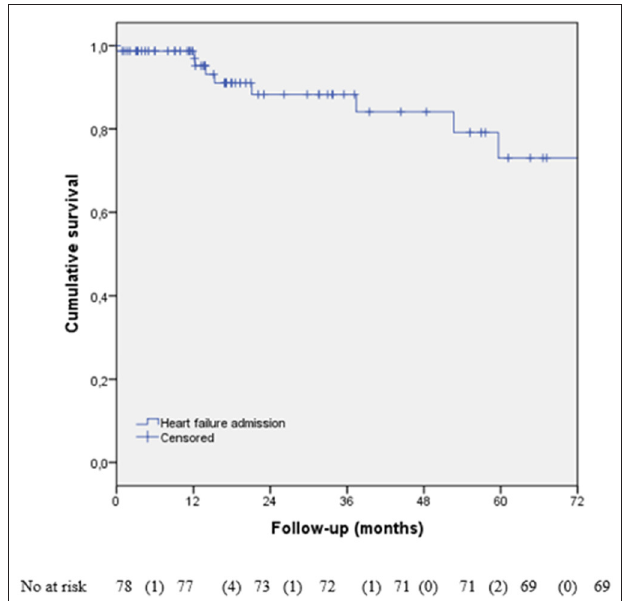
FIGURE 1 | Kaplan–Meier analysis of heart failure (HF) hospital admission during follow-up. We have lost data about HF admission in the 35 patients.